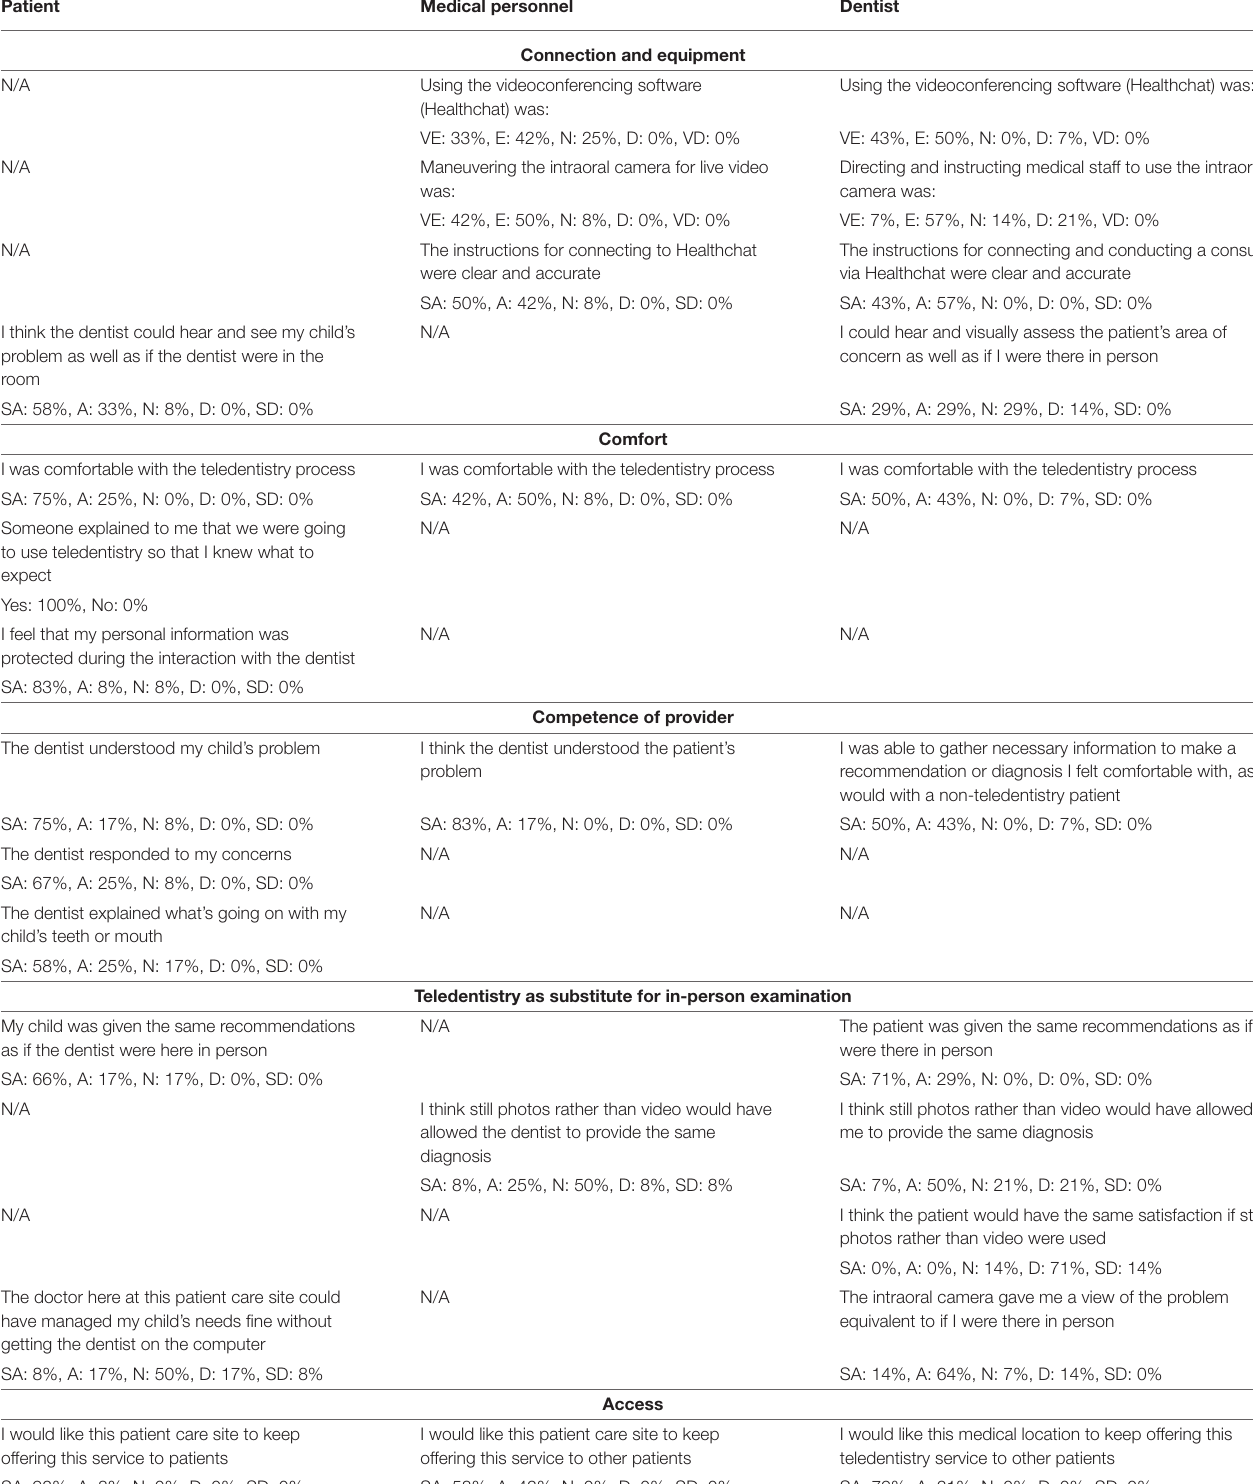
TABLE 2 | Selection of teledentistry survey questions by domain. Patient Medical personnel Dentist Connection and